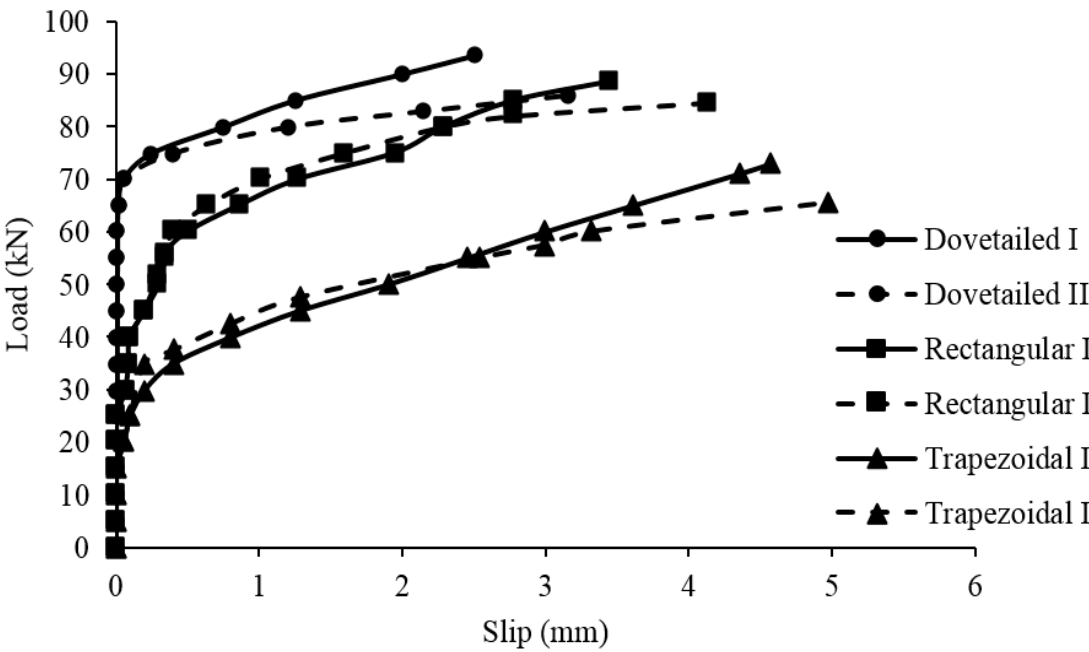
Figure 12. Load versus slip curve of profiled composite slabs for trials I and II.